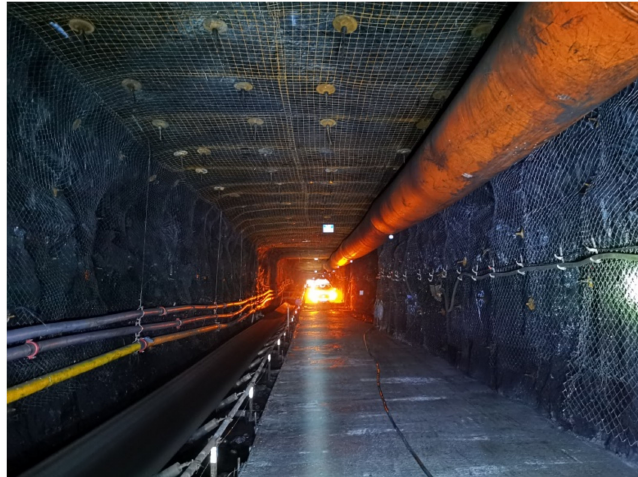
Figure 15. Photos of roadway support